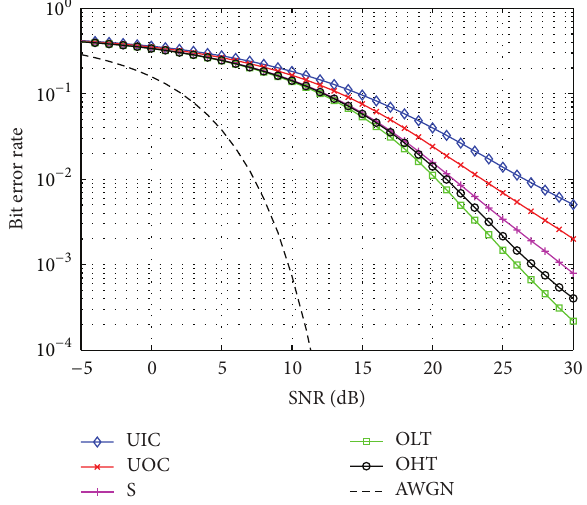
Figure 5: Bit error rate of the TDL based non-WSSUS V2V channel model in OFDM systems (five scenarios: UIC, UOC, Small City, OLT, and